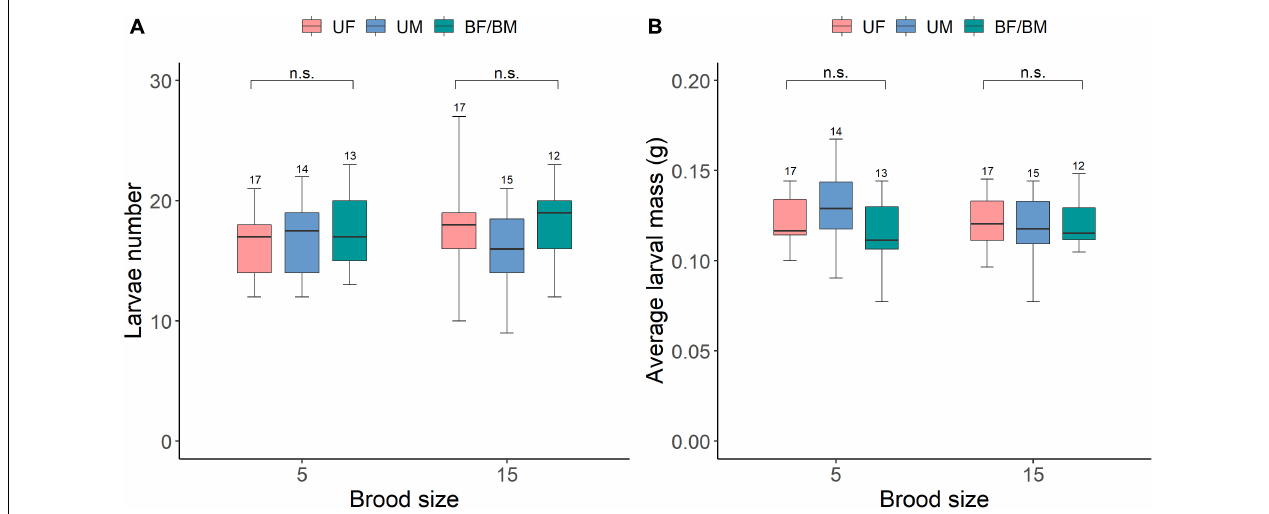
FIGURE 5 | The carry over effects of parental care system (uniparental male, uniparental female, biparental care) and brood size (5 vs. 15 larvae) in the first breeding on (A) larvae number and (B) average larval mass at dispersal in the second breeding. Boxplots show median, interquartile range, and minimum/maximum range. Numbers above error bars are sample sizes. For statistical analyses see Table 5 . n.s., not significant; UM, uniparental male; UF, uniparental female; BM, biparental male; BF, biparental